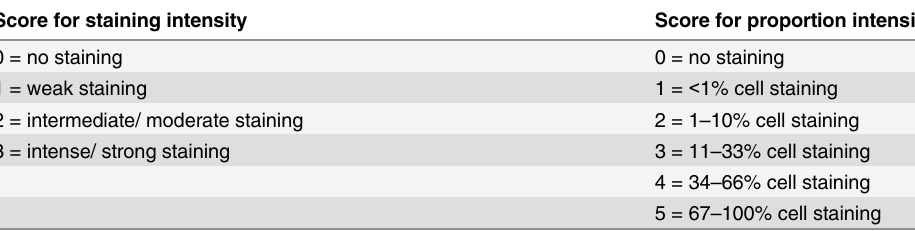
Table 2. Scoring system.